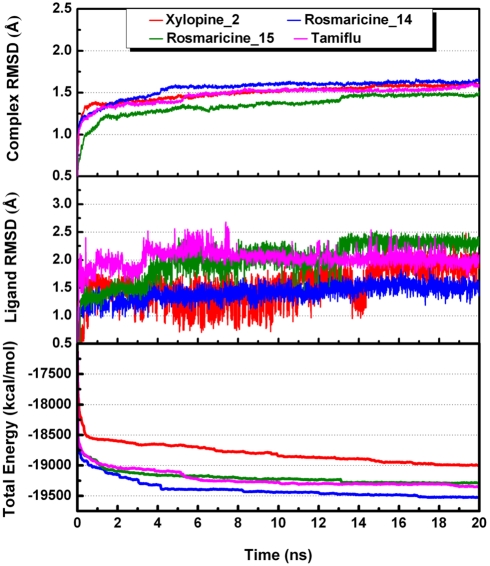
RMSD and total energy profiles of top three de novo derivatives and Tamiflu® in N1 complexes during 20 ns MD simulation.